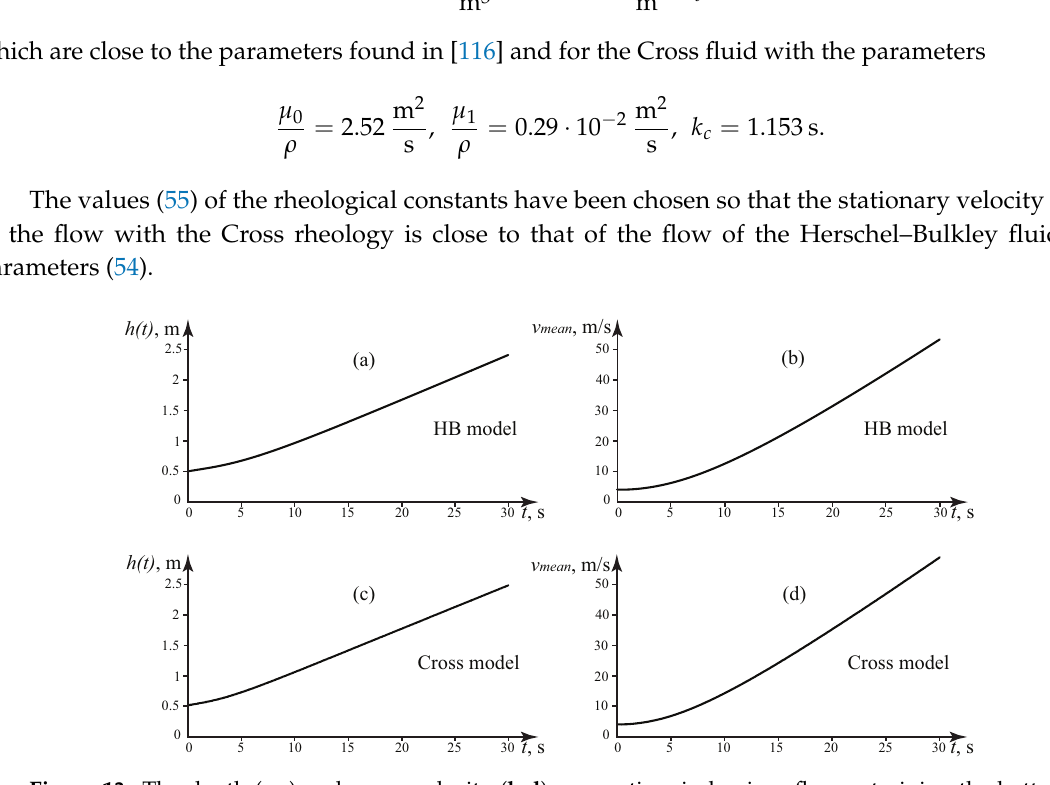
Figure 13. The depth ( a , c ) and mean velocity ( b , d ) versus time in laminar flow entraining the bottom material. ( a , b ) the Herschel–Bulkley fluid; ( c , d ) the Cross fluid.